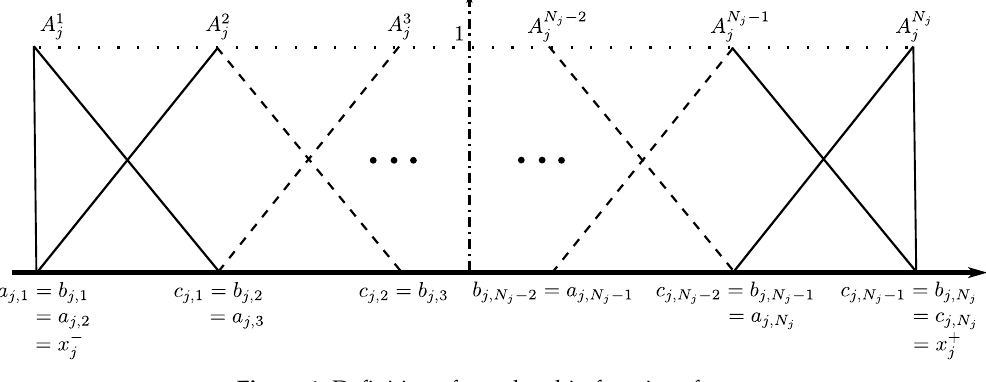
Figure 1. Definition of membership functions for x j